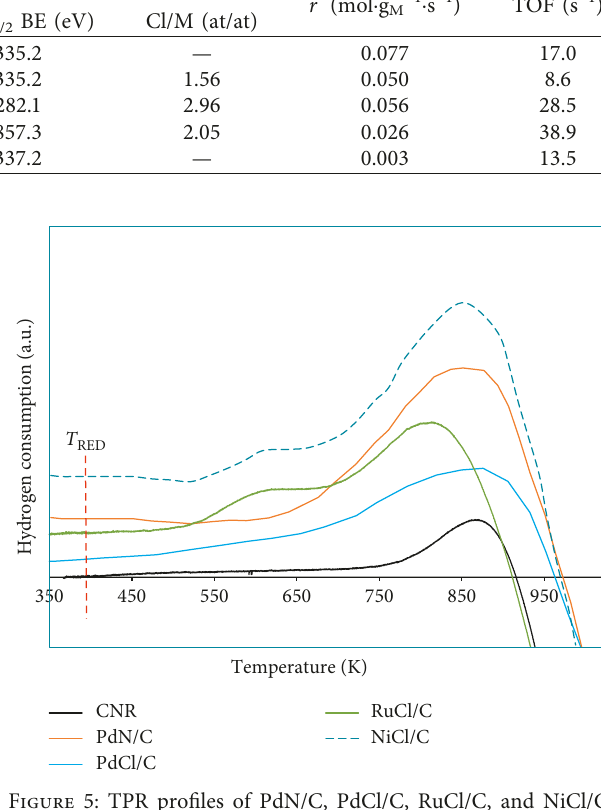
Table 2: Metal loading, dispersion, particle diameter, XPS, initial reaction rate, and activity (TOF) results for the catalysts. Catalysts Metal loading